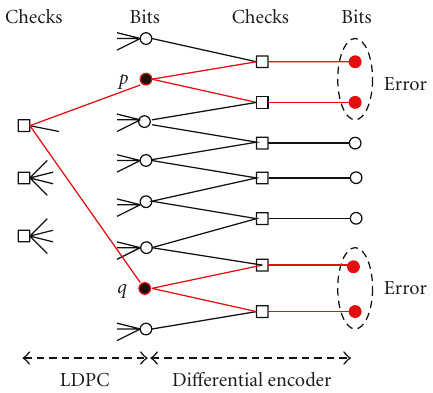
Figure 3: Defect for λ (cid:3) 1 > 1 − R . When the four bits associated with the solid circles flip altogether, another valid codeword results, and the decoder is unable to tell (undetectable